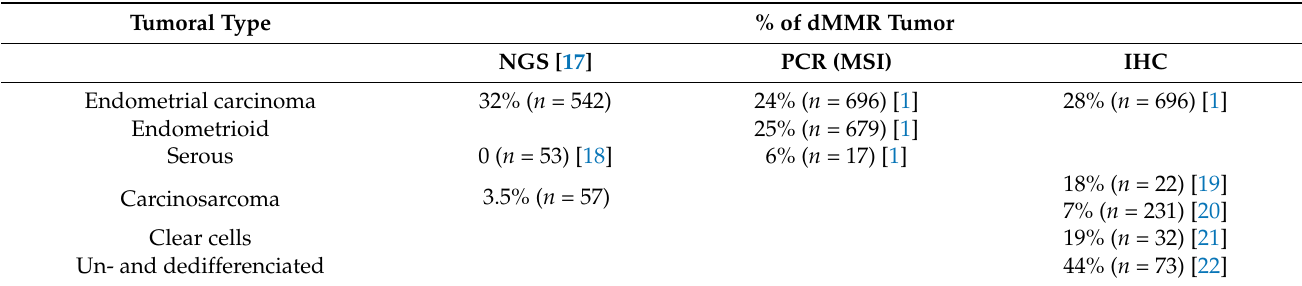
Table 2. dMMR status in endometrial